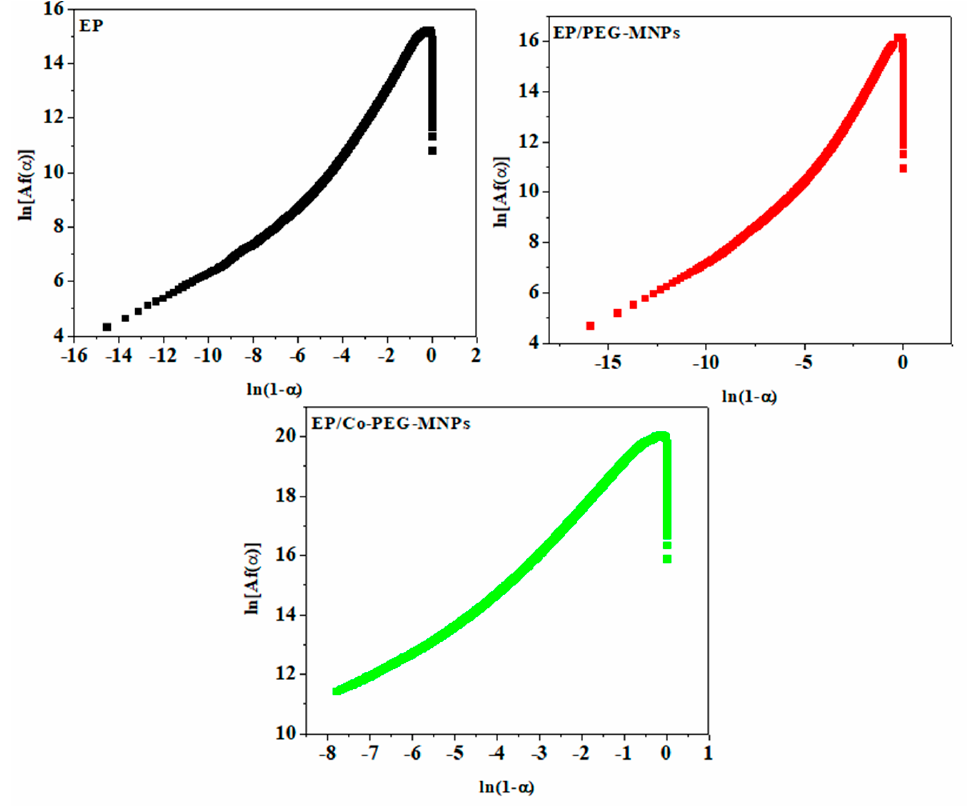
Figure A3. Arrays of ln [Af( α )] plots vs. ln( 1 - α ) as typical plots obtained for the studied samples using Friedman model.